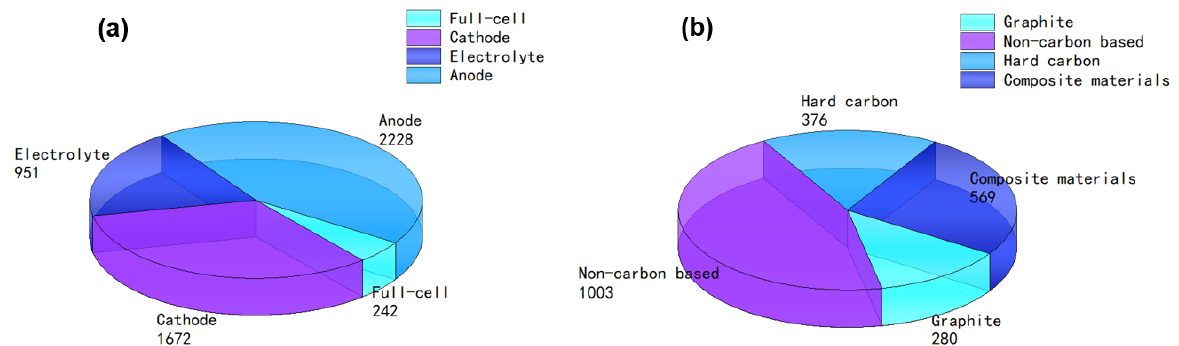
Figure 1. Rough count number of studies published in the last five years (obtained from Web of Science core-collection database, from 2018 and data up to August in 2022). ( a ) The direction of studies published in the SIB field (left). ( b ) Various materials studies published in the anodic direction